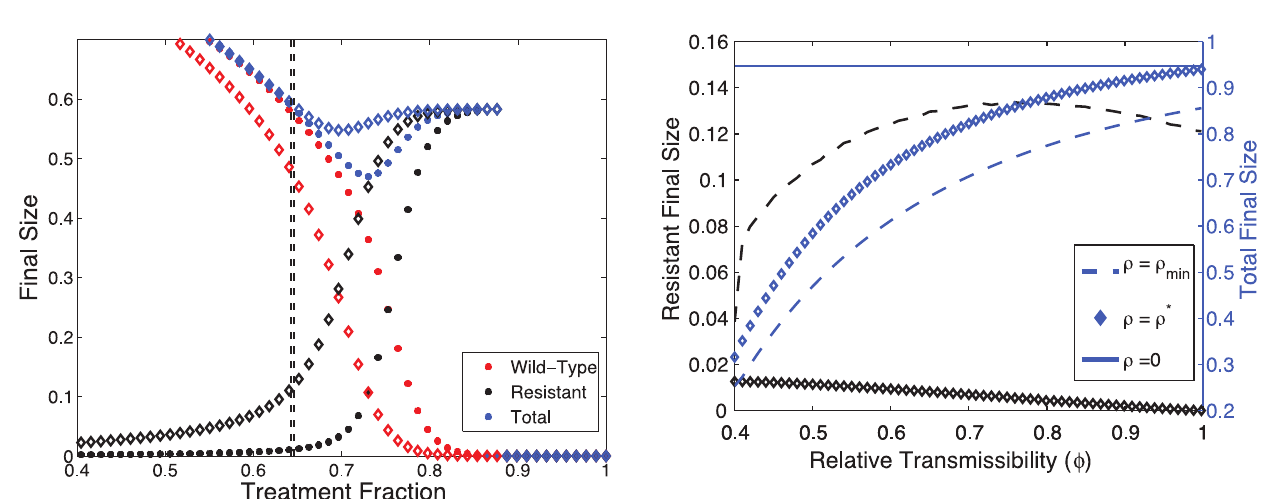
Figure 6. Final epidemic size of both strains vs. r . ( c ~ 0 : 002 as asterisks and c ~ 0 : 02 as diamonds) Vertical dashed lines represent r (cid:3) ( c ) ; higher c , lower r (cid:3) . Note that r (cid:3) is effective in halting the spread of resistance but not in reducing the total FS. Also, for larger c , r (cid:3) loses its effectiveness in avoiding the spread of resistance. Other parameters: b u ~ 0 : 6, w ~ 0 : 5 .